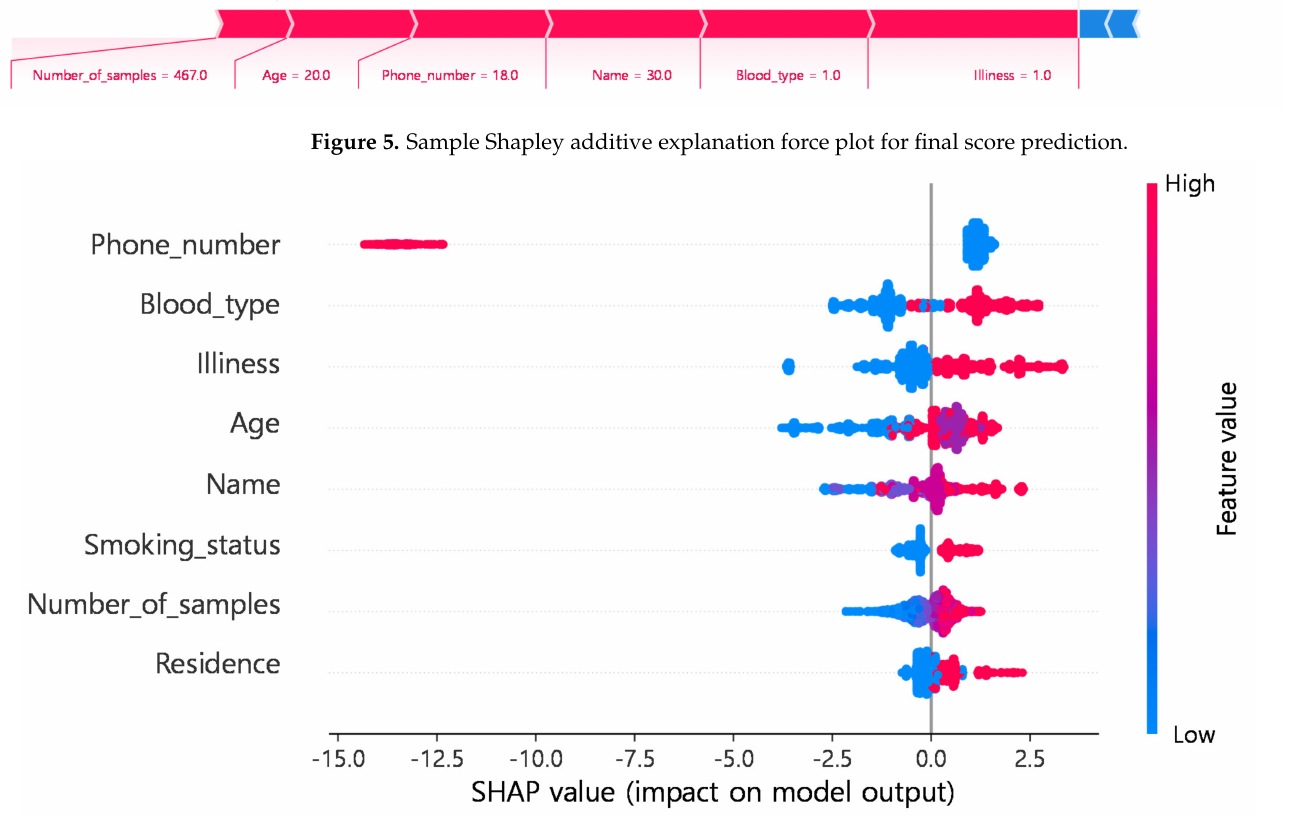
Figure 6. Summary plot of selected Shapley additive explanation (SHAP)